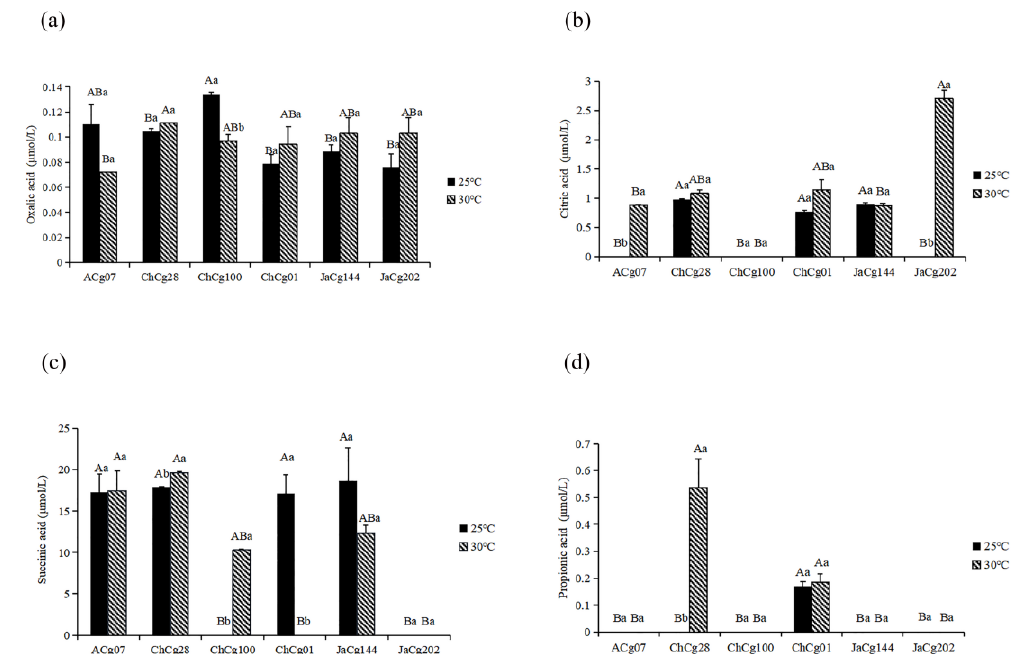
Figure 3. Organic acid concentrations of the six Cenococcum geophilum isolates under control and high temperature treatments. ( a ) oxalic acid, ( b ) citric acid, ( c ) succinic acid, ( d ) propionic acid. The data showed the mean ± SD for 25 ◦ C and 30 ◦ C replicates ( n = 3). Uppercase indicates the difference between different isolates at the same temperature (Kruskal–Wallis test, p < 0.05), lowercase indicates the difference between different temperatures of the same isolate (Student’s t test, p < 0.05).